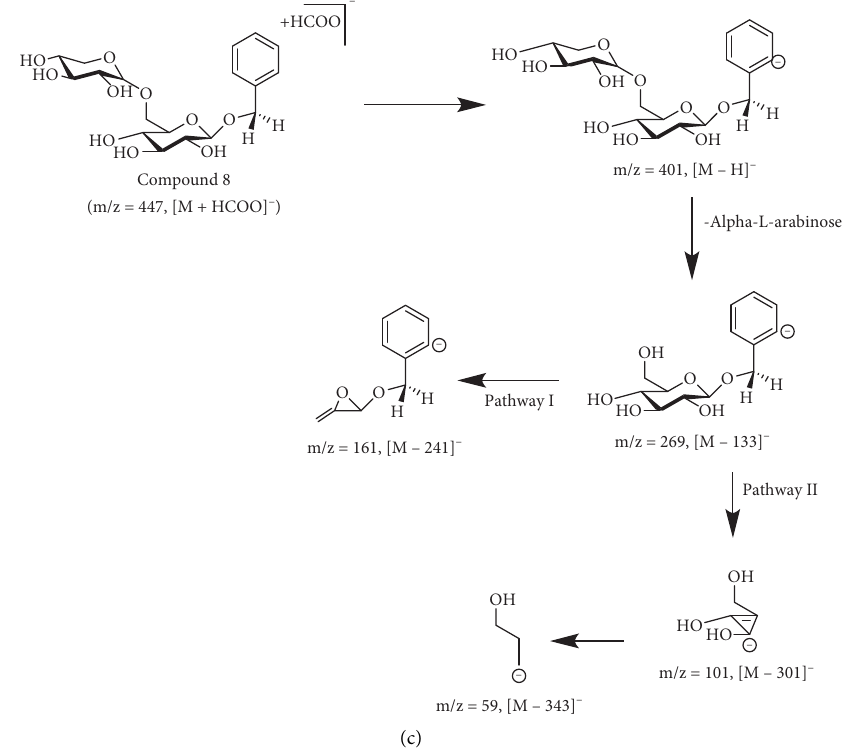
Figure 2: The predicted MS/MS fragmentation pathways of compounds 1–9 in positive and negative